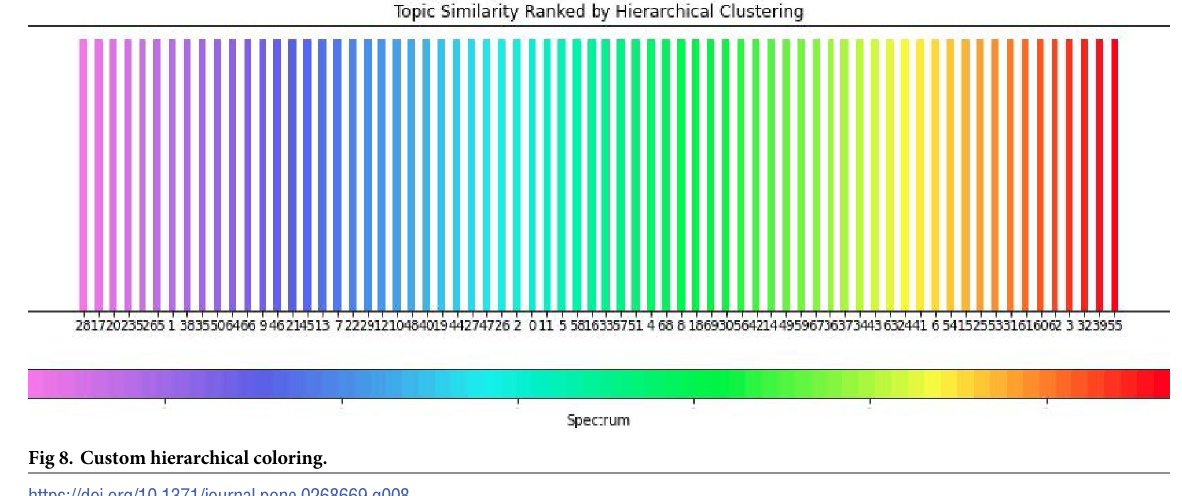
Fig 8. Custom hierarchical